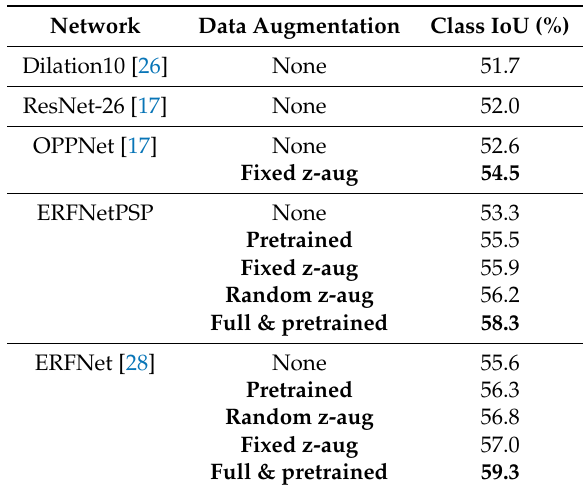
Table 2. Architectures and data augmentation